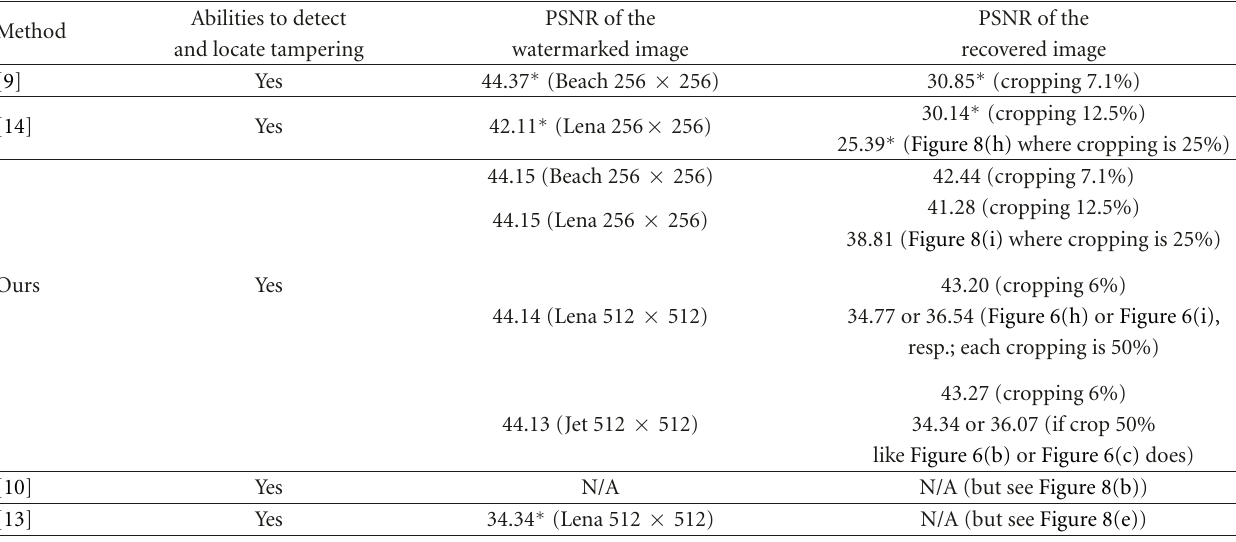
Table 1: A comparison between the reported recovery methods and the proposed method. (“ ∗ ” means “quoted directly from the reported paper”, and “N/A” means not mentioned in the reported paper). The unit of PSNR is the dB.